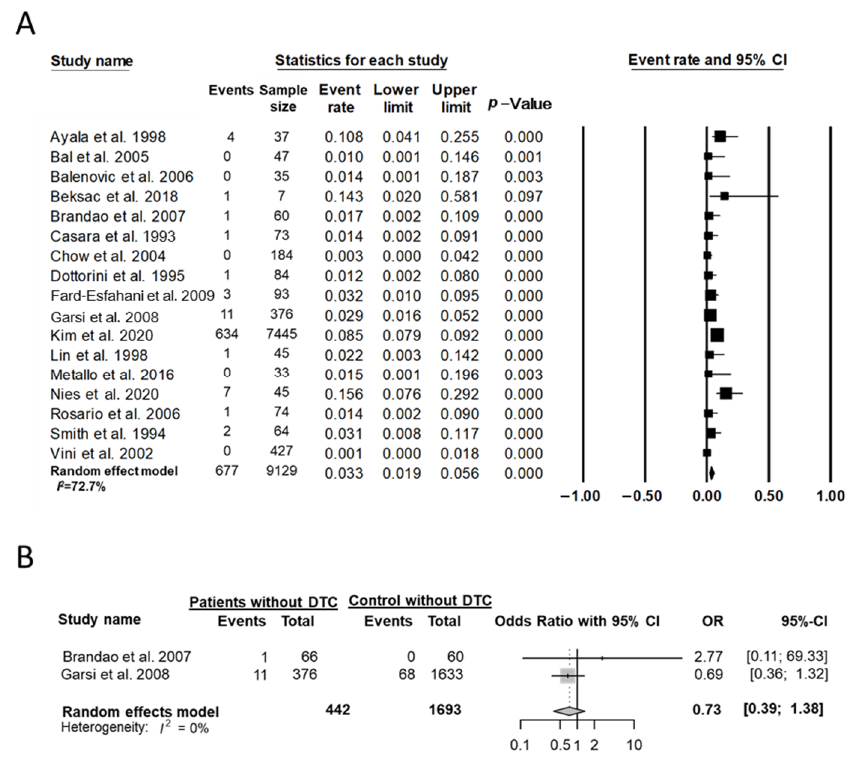
Figure 4. Effect of treatment of DTC on congenital anomalies. ( A ) Event rate among cases of pregnancy and ( B ) the OR between patients with DTC and controls without DTC. Studies referenced: